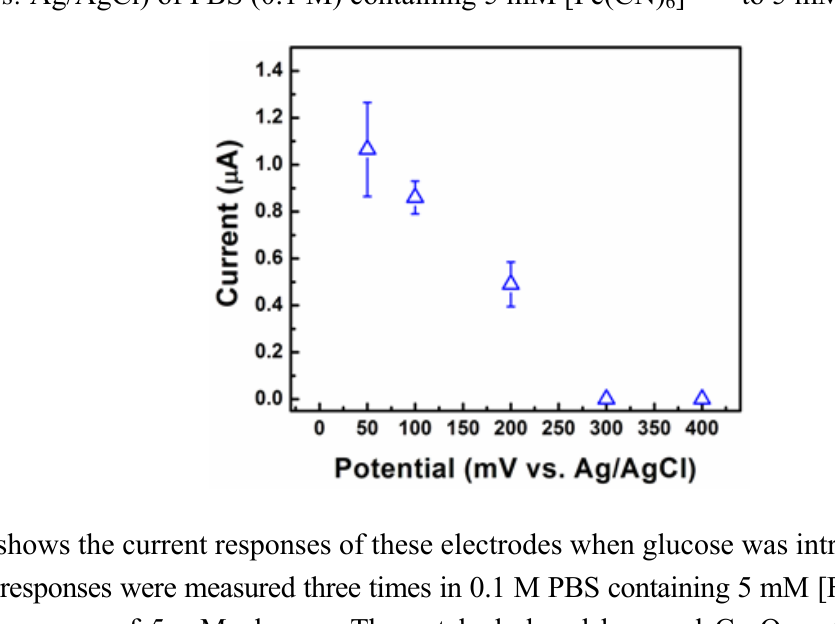
Figure 6. Amperometric responses of the electrode with Cu (mV vs. Ag/AgCl) of PBS (0.1 M) containing 5 mM [Fe(CN)